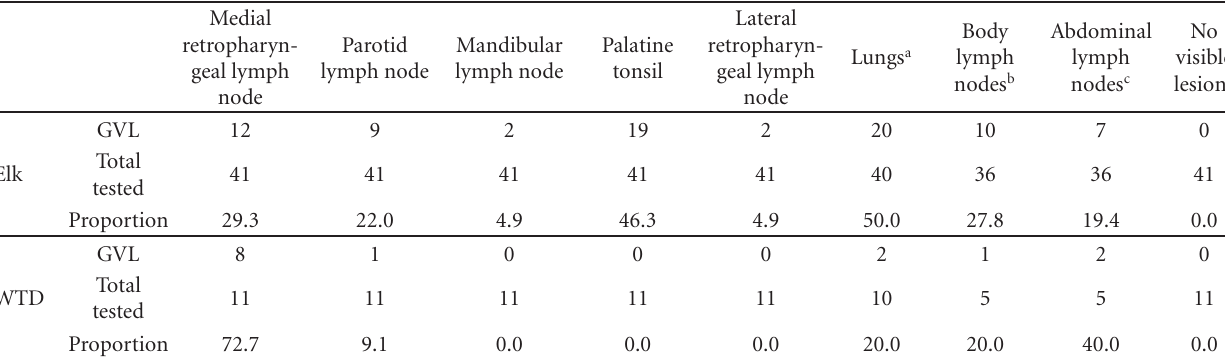
Table 3: Site of gross visible lesions (GVL) in M. bovis positive elk and white-tailed deer from south-western